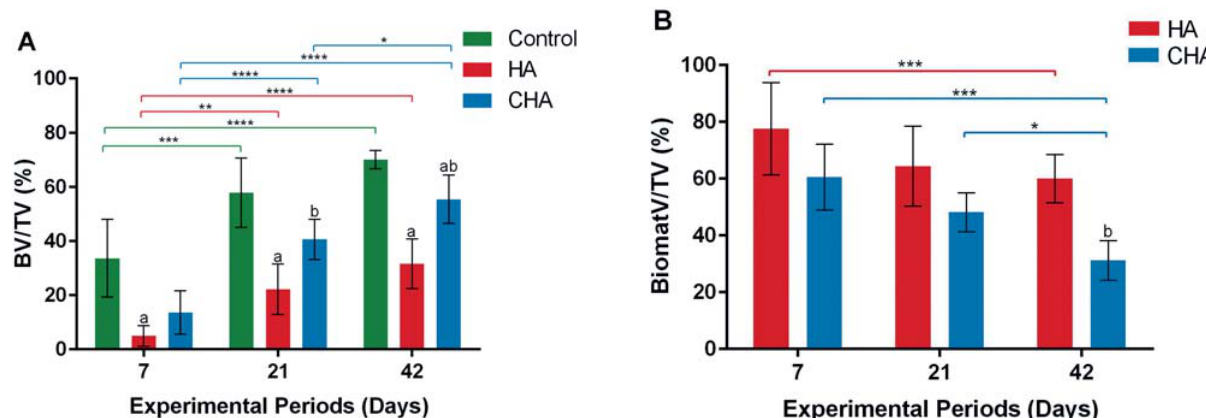
Figure 9- The bone volume density (BV/TV%) (A), and biomaterials volume density (BiomatV/TV%) (B) after 7, 21, and (cid:23)(cid:21)(cid:3)(cid:71)(cid:68)(cid:92)(cid:86)(cid:3)(cid:82)(cid:73)(cid:3)(cid:76)(cid:80)(cid:83)(cid:79)(cid:68)(cid:81)(cid:87)(cid:68)(cid:87)(cid:76)(cid:82)(cid:81)(cid:17)(cid:3)(cid:11)(cid:68)(cid:12)(cid:3)(cid:86)(cid:76)(cid:74)(cid:81)(cid:76)(cid:191)(cid:70)(cid:68)(cid:81)(cid:87)(cid:3)(cid:86)(cid:87)(cid:68)(cid:87)(cid:76)(cid:86)(cid:87)(cid:76)(cid:70)(cid:68)(cid:79)(cid:3)(cid:71)(cid:76)(cid:73)(cid:73)(cid:72)(cid:85)(cid:72)(cid:81)(cid:70)(cid:72)(cid:86)(cid:3)(cid:69)(cid:72)(cid:87)(cid:90)(cid:72)(cid:72)(cid:81)(cid:3)(cid:75)(cid:92)(cid:71)(cid:85)(cid:82)(cid:91)(cid:92)(cid:68)(cid:83)(cid:68)(cid:87)(cid:76)(cid:87)(cid:72)(cid:3)(cid:11)(cid:43)(cid:36)(cid:12)(cid:3)(cid:82)(cid:85)(cid:3)(cid:81)(cid:68)(cid:81)(cid:82)(cid:86)(cid:87)(cid:85)(cid:88)(cid:70)(cid:87)(cid:88)(cid:85)(cid:72)(cid:71)(cid:3)(cid:70)(cid:68)(cid:85)(cid:69)(cid:82)(cid:81)(cid:68)(cid:87)(cid:72)(cid:71)(cid:3) (cid:75)(cid:92)(cid:71)(cid:85)(cid:82)(cid:91)(cid:92)(cid:68)(cid:83)(cid:68)(cid:87)(cid:76)(cid:87)(cid:72)(cid:18)(cid:70)(cid:68)(cid:79)(cid:70)(cid:76)(cid:88)(cid:80)(cid:3)(cid:68)(cid:79)(cid:74)(cid:76)(cid:81)(cid:68)(cid:87)(cid:72)(cid:3)(cid:11)(cid:38)(cid:43)(cid:36)(cid:12)(cid:3)(cid:70)(cid:82)(cid:80)(cid:83)(cid:68)(cid:85)(cid:72)(cid:71)(cid:3)(cid:90)(cid:76)(cid:87)(cid:75)(cid:3)(cid:70)(cid:82)(cid:81)(cid:87)(cid:85)(cid:82)(cid:79)(cid:3)(cid:74)(cid:85)(cid:82)(cid:88)(cid:83)(cid:3)(cid:68)(cid:87)(cid:3)(cid:87)(cid:75)(cid:72)(cid:3)(cid:86)(cid:68)(cid:80)(cid:72)(cid:3)(cid:72)(cid:91)(cid:83)(cid:72)(cid:85)(cid:76)(cid:80)(cid:72)(cid:81)(cid:87)(cid:68)(cid:79)(cid:3)(cid:83)(cid:72)(cid:85)(cid:76)(cid:82)(cid:71)(cid:30)(cid:3)(cid:11)(cid:69)(cid:12)(cid:3)(cid:86)(cid:76)(cid:74)(cid:81)(cid:76)(cid:191)(cid:70)(cid:68)(cid:81)(cid:87)(cid:3)(cid:86)(cid:87)(cid:68)(cid:87)(cid:76)(cid:86)(cid:87)(cid:76)(cid:70)(cid:68)(cid:79)(cid:3) (cid:71)(cid:76)(cid:73)(cid:73)(cid:72)(cid:85)(cid:72)(cid:81)(cid:70)(cid:72)(cid:86)(cid:3)(cid:69)(cid:72)(cid:87)(cid:90)(cid:72)(cid:72)(cid:81)(cid:3)(cid:38)(cid:43)(cid:36)(cid:3)(cid:68)(cid:81)(cid:71)(cid:3)(cid:43)(cid:36)(cid:3)(cid:68)(cid:87)(cid:3)(cid:87)(cid:75)(cid:72)(cid:3)(cid:86)(cid:68)(cid:80)(cid:72)(cid:3)(cid:72)(cid:91)(cid:83)(cid:72)(cid:85)(cid:76)(cid:80)(cid:72)(cid:81)(cid:87)(cid:68)(cid:79)(cid:3)(cid:83)(cid:72)(cid:85)(cid:76)(cid:82)(cid:71)(cid:30)(cid:3)(cid:11)(cid:13)(cid:12)(cid:3)(cid:86)(cid:76)(cid:74)(cid:81)(cid:76)(cid:191)(cid:70)(cid:68)(cid:81)(cid:87)(cid:3)(cid:86)(cid:87)(cid:68)(cid:87)(cid:76)(cid:86)(cid:87)(cid:76)(cid:70)(cid:68)(cid:79)(cid:3)(cid:71)(cid:76)(cid:73)(cid:73)(cid:72)(cid:85)(cid:72)(cid:81)(cid:70)(cid:72)(cid:3)(cid:69)(cid:72)(cid:87)(cid:90)(cid:72)(cid:72)(cid:81)(cid:3)(cid:87)(cid:75)(cid:72)(cid:3)(cid:86)(cid:68)(cid:80)(cid:72)(cid:3) (cid:74)(cid:85)(cid:82)(cid:88)(cid:83)(cid:3)(cid:68)(cid:87)(cid:3)(cid:71)(cid:76)(cid:73)(cid:73)(cid:72)(cid:85)(cid:72)(cid:81)(cid:87)(cid:3)(cid:72)(cid:91)(cid:83)(cid:72)(cid:85)(cid:76)(cid:80)(cid:72)(cid:81)(cid:87)(cid:68)(cid:79)(cid:3)(cid:83)(cid:72)(cid:85)(cid:76)(cid:82)(cid:71)(cid:86)(cid:3)(cid:11)(cid:87)(cid:90)(cid:82)(cid:16)(cid:90)(cid:68)(cid:92)(cid:3)(cid:36)(cid:49)(cid:50)(cid:57)(cid:36)(cid:15)(cid:3)(cid:83)(cid:31)(cid:19)(cid:17)(cid:19)(cid:24)(cid:12)(cid:17)(cid:3)(cid:53)(cid:72)(cid:86)(cid:88)(cid:79)(cid:87)(cid:86)(cid:3)(cid:68)(cid:85)(cid:72)(cid:3)(cid:86)(cid:75)(cid:82)(cid:90)(cid:81)(cid:3)(cid:68)(cid:86)(cid:3)(cid:80)(cid:72)(cid:68)(cid:81)(cid:3)(cid:83)(cid:72)(cid:85)(cid:70)(cid:72)(cid:81)(cid:87)(cid:68)(cid:74)(cid:72)(cid:86)(cid:147)(cid:70)(cid:82)(cid:81)(cid:191)(cid:71)(cid:72)(cid:81)(cid:70)(cid:72)(cid:3)